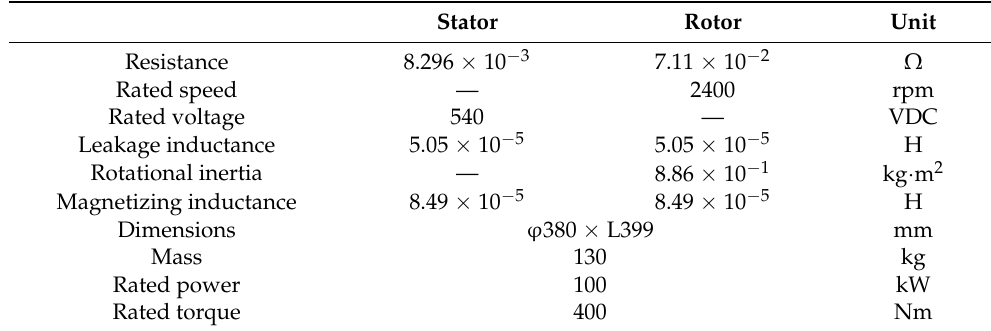
Table 1. Key parameters of PMSMs.